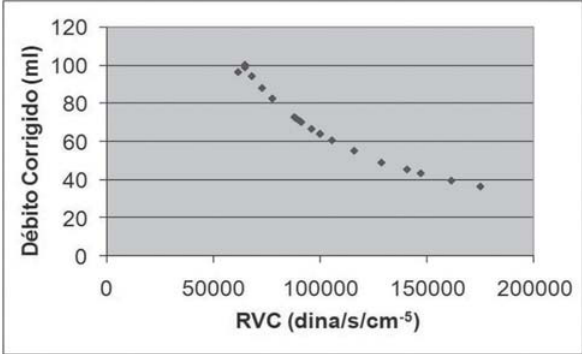
Fig. 2 - Estudo dos casos. Fluxo sanguíneo (100 ml/min) pelo